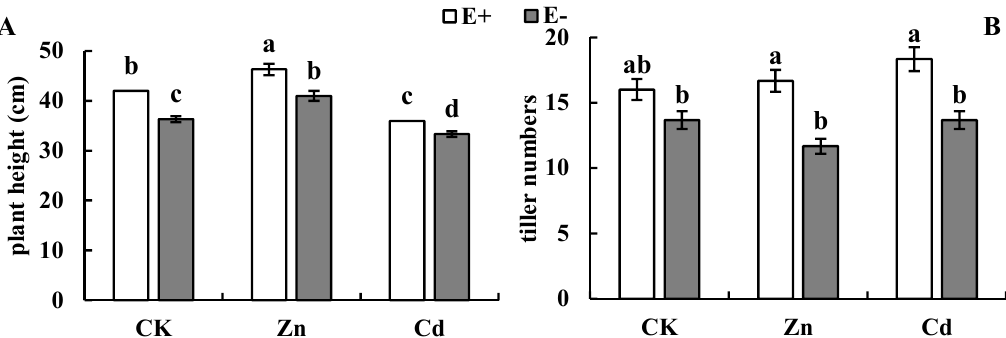
Figure 1. Effect of Epichloë endophyte and Cd 2+ and Zn 2+ treatments on plant height ( A ) and tiller number ( B ) of F. sinensis . Note: Different lowercase letters indicate significant differences between treatments ( p < 0.05).